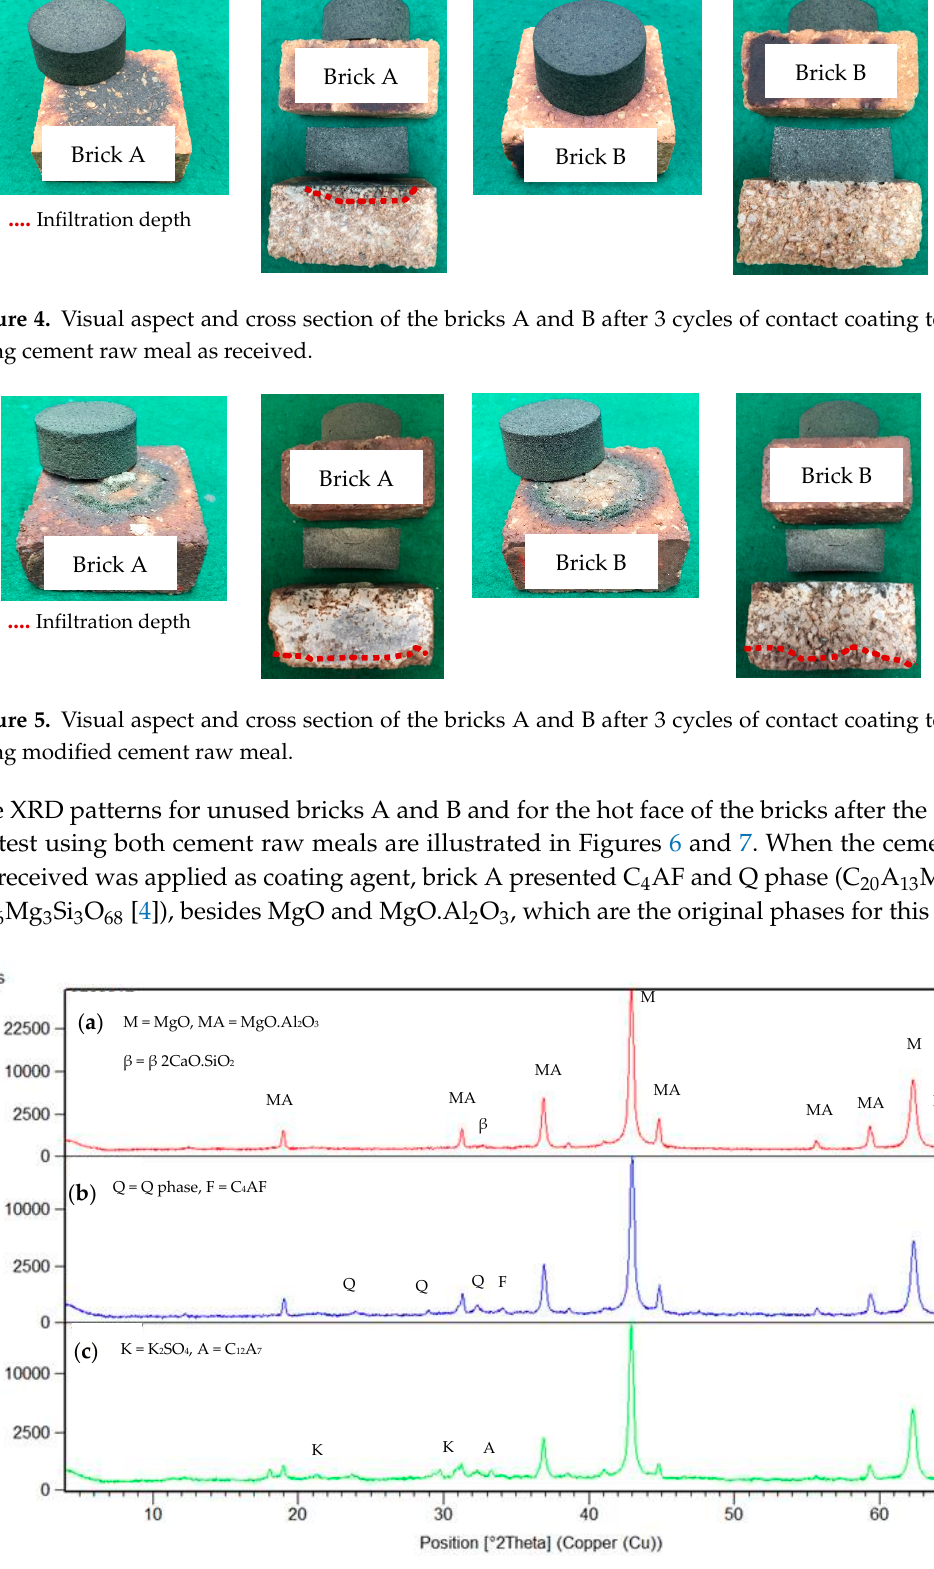
Figure 4. Visual aspect and cross section of the bricks A and B after 3 cycles of contact coating test using cement raw meal as received.